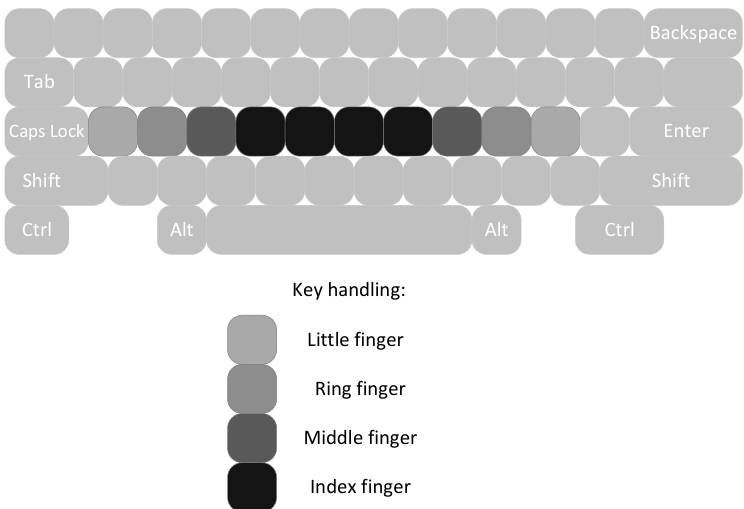
Figure 2. Example of keyboard arrangement of ORK+ type with 10 letter keys.